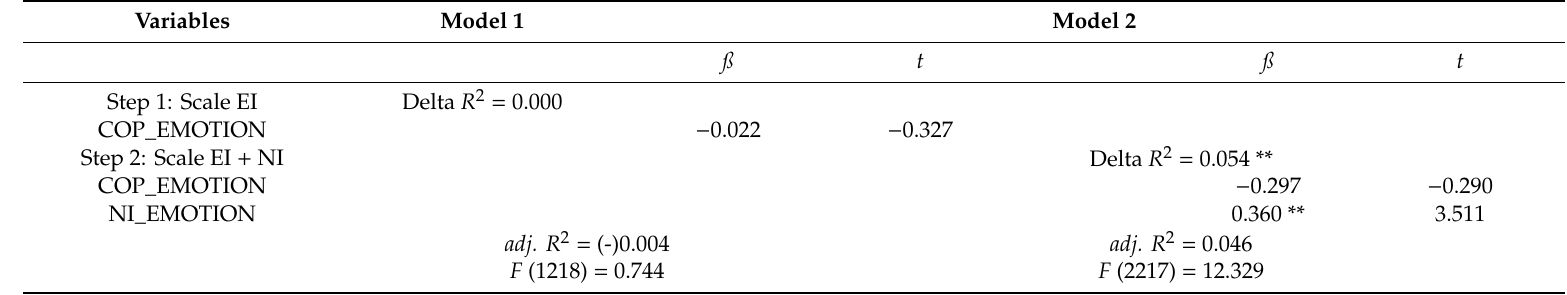
Table A9. Hierarchical regression analyses for the relation between well-being and scales from existing instruments (EI) and the new instrument (NI) assessing (no) emotional challenges at